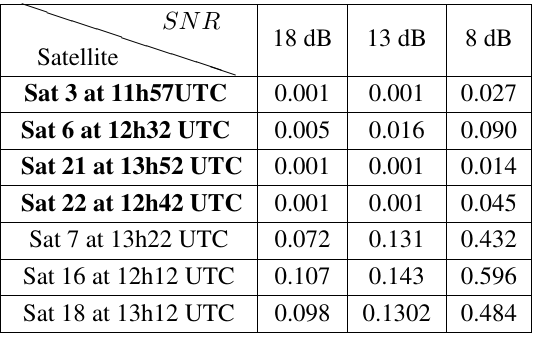
Table 1. RMSE of the estimated height ˆ h , in meters, for an observation interval of 600 s. Reference height h = 2 m and α